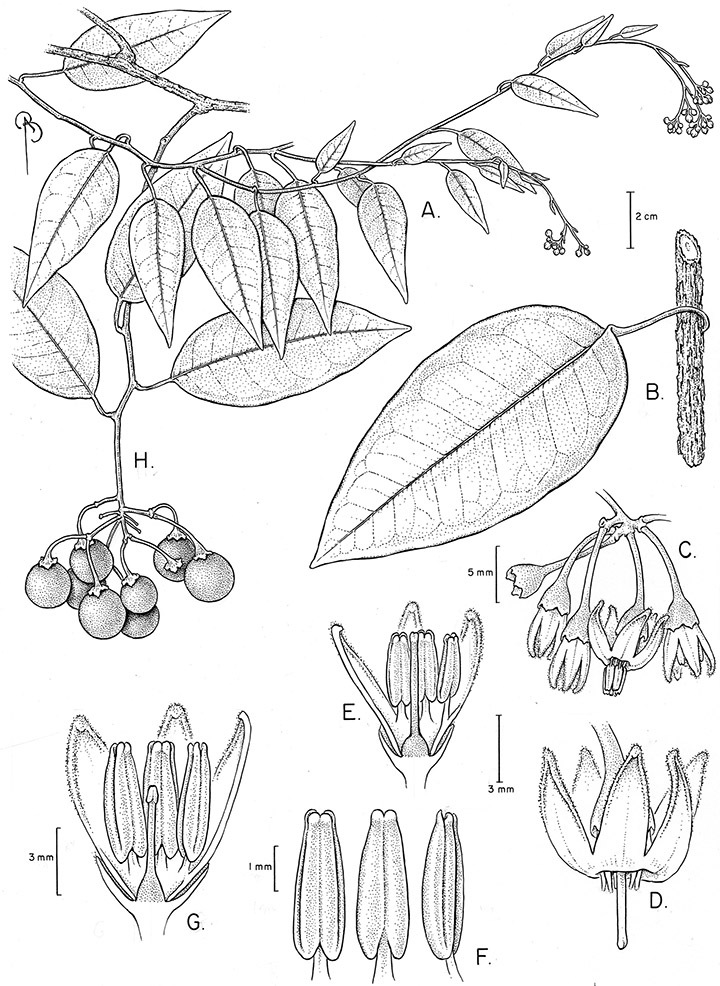
Solanum luculentum S.Knapp. (A–B drawn from Nee & Callejas 32546
C–F from Steyermark et al. 127855, G from Steyermark & Dunsterville 100777
H from Killip & Smith 15952). Originally published in Knapp (2010). Illustration by Bobbi Angell.